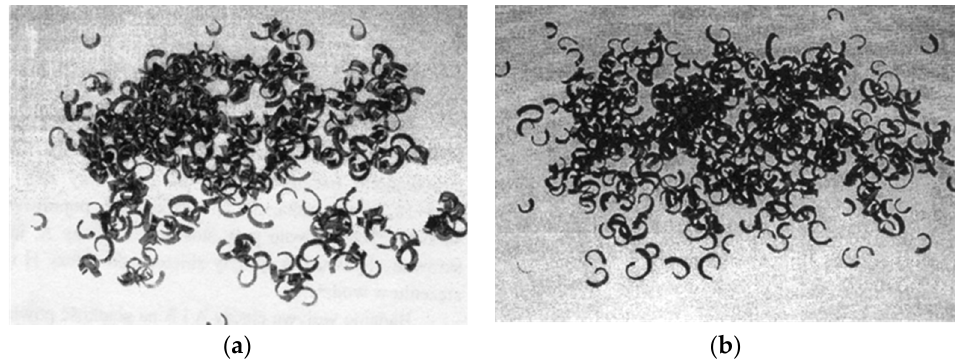
Figure 14. Examples of chips from straight turning using original fluid ( a ) and reference (commercial) fluid ( b ).